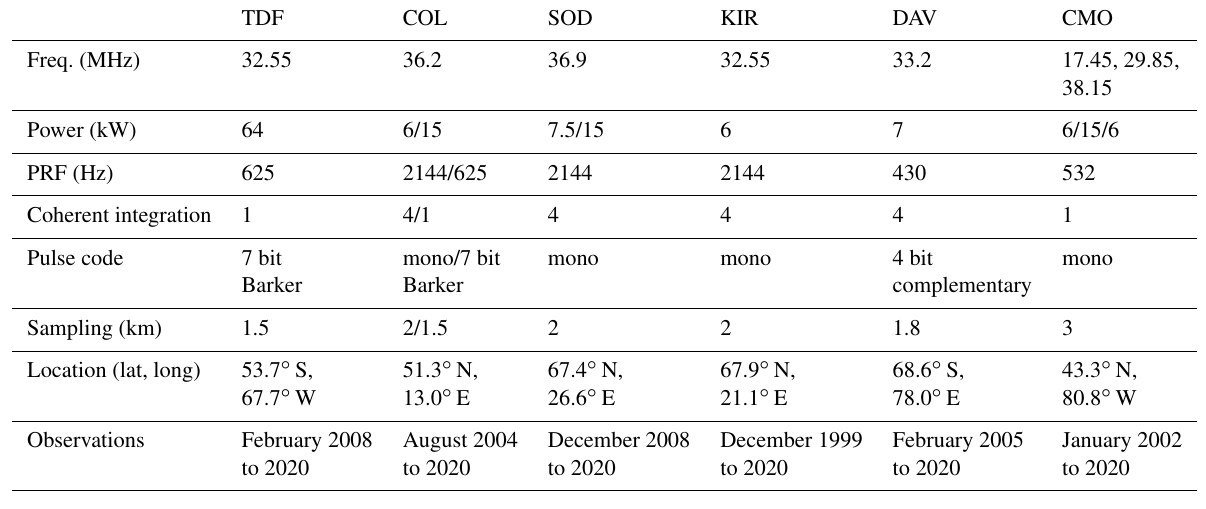
Table 1. Technical parameters of the meteor radars and experiment settings.